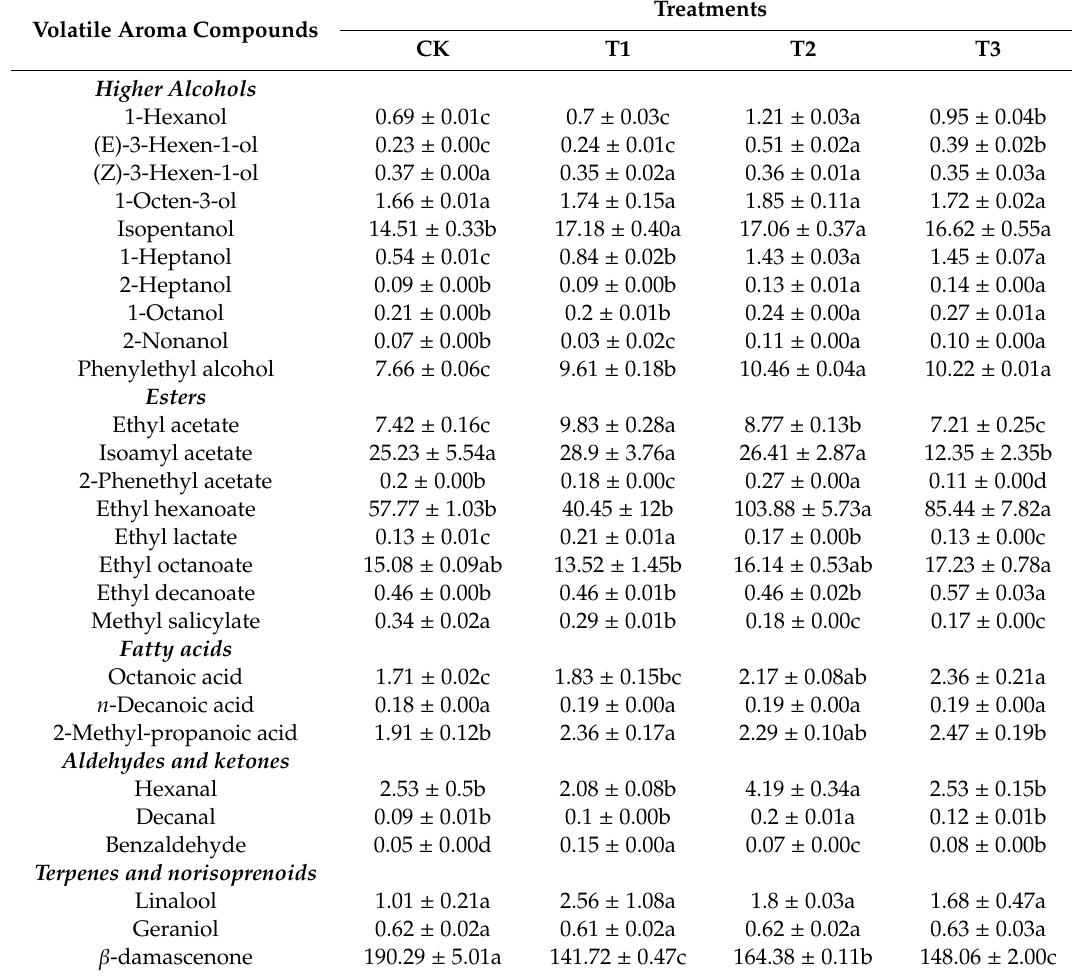
Table 4. Odor activity values (OAVs) of main aroma compounds (OAV > 0.1) determined in the Cabernet Sauvignon wines produced from control berries (CK) and sequential harvest berries (T2, T3, and